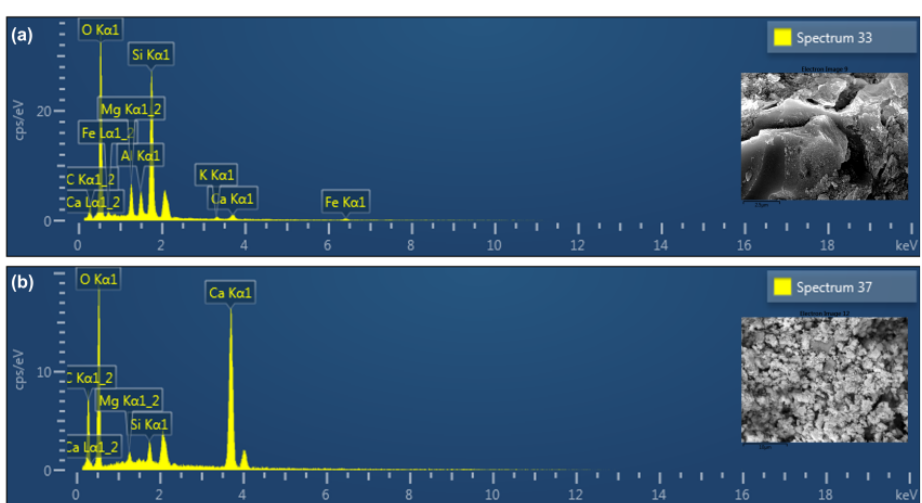
Figure 10. Scanning electron microscope (SEM) image of a part of mural sample. ( a ) Earthen layer. ( b ) Lime layer. ( c ) Fiber in lime layer. ( d ) shell in lime layer.